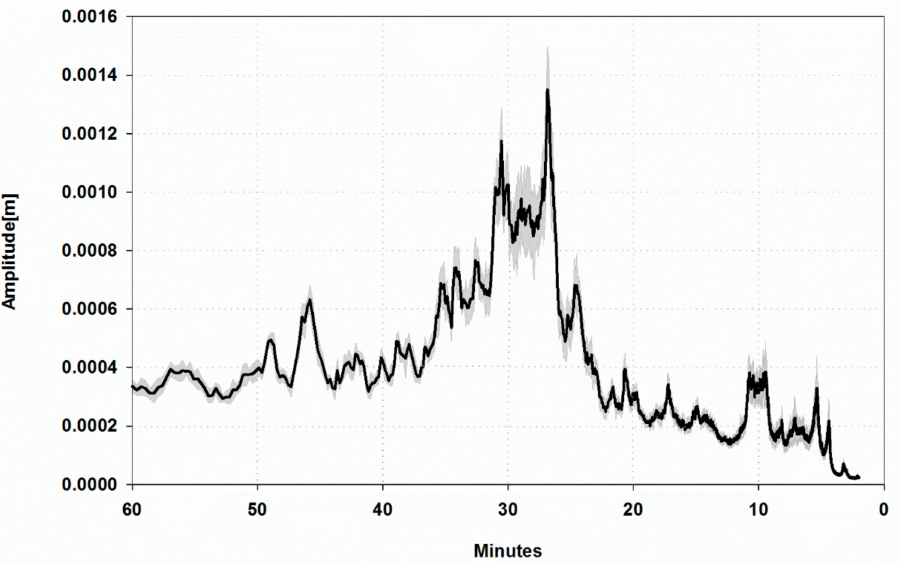
Figure 3. FFT spectrum of sea-level residuals in the band (2–60 min) averaged from the eight yearly spectra. Mean (black) and standard deviation